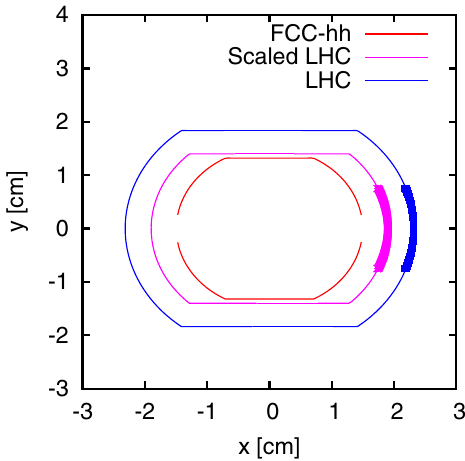
FIG. 8. Vacuum chamber cross sections for FCC-hh, LHC, and scaled LHC chambers. The thicker line represents the sawtooth on the wall, and the transparent region is an opening slot (modeled as a perfect absorber).